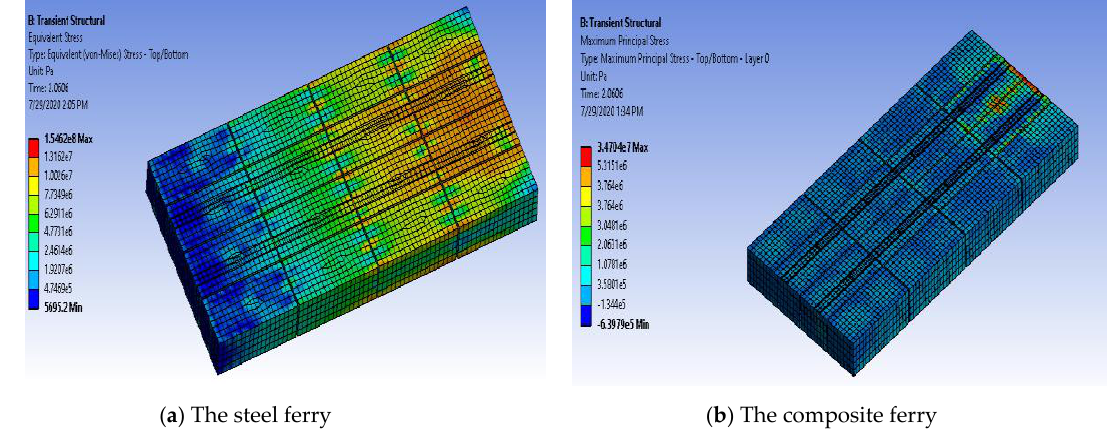
Figure 21. Stress distribution over the ferries for case 1.